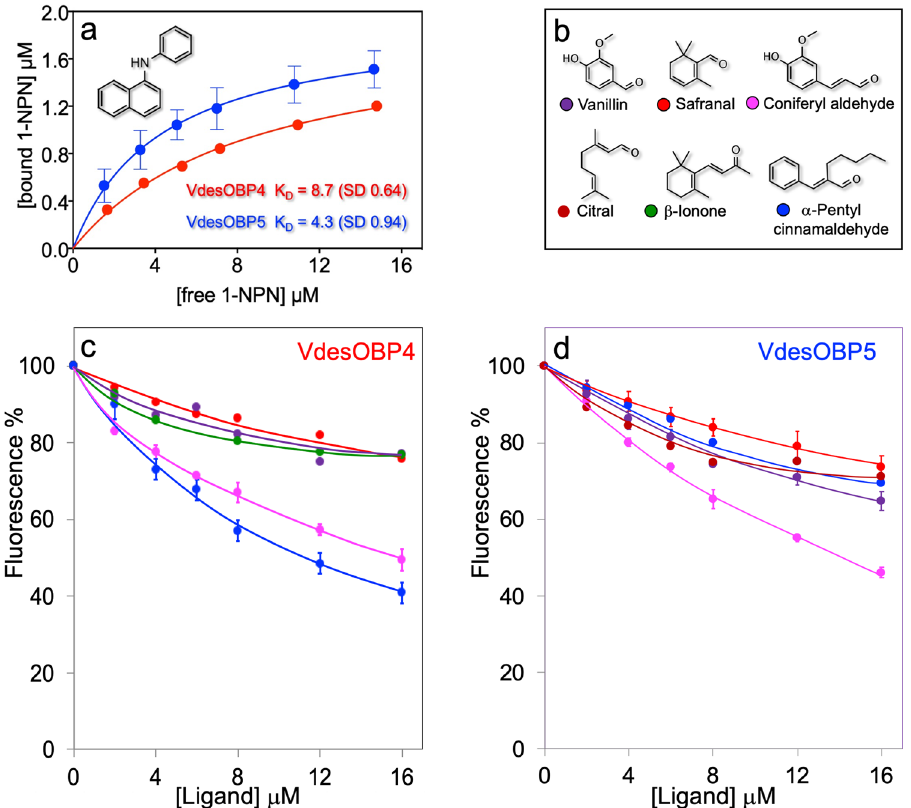
Figure 8. Ligand-binding assays. ( a ) Binding of the fluorescent probe N-phenylnaphthylamine (1-NPN) to VdesOBP4 and VdesOBP5. With the other two proteins expressed (VdesOBP1 and VdesOBP2), we could not observe the blue shift usually associated with binding of the fluorescent probe. ( b ) Structures of the ligand used in the competitive binding experiments. ( c,d ) Competitive binding assays. Only few chemicals were able to displace 1-NPN from the complex with VdesOBP4 and VdesOBP5. The same chemicals were also the best ligands for the other VdesOBPs (Supplementary Fig. S3